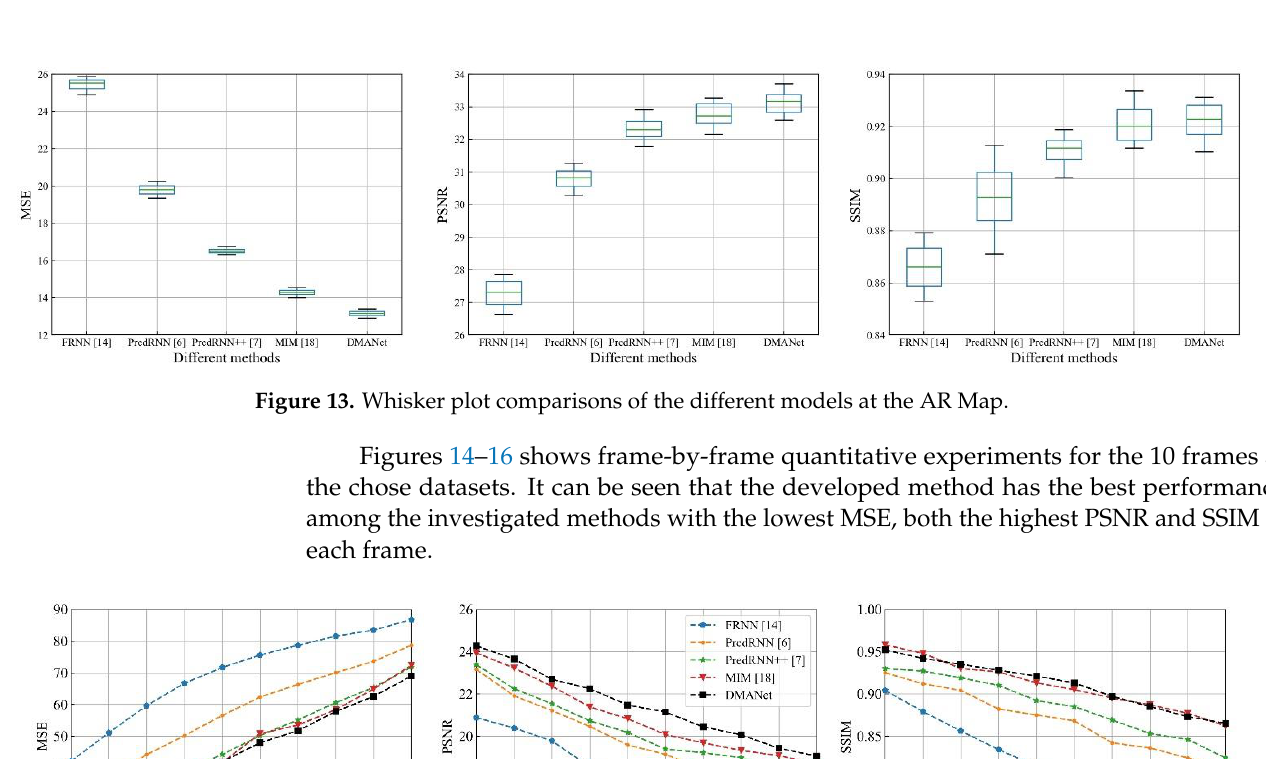
Figure 12. Whisker plot comparisons of the different models at the Caltech [36].